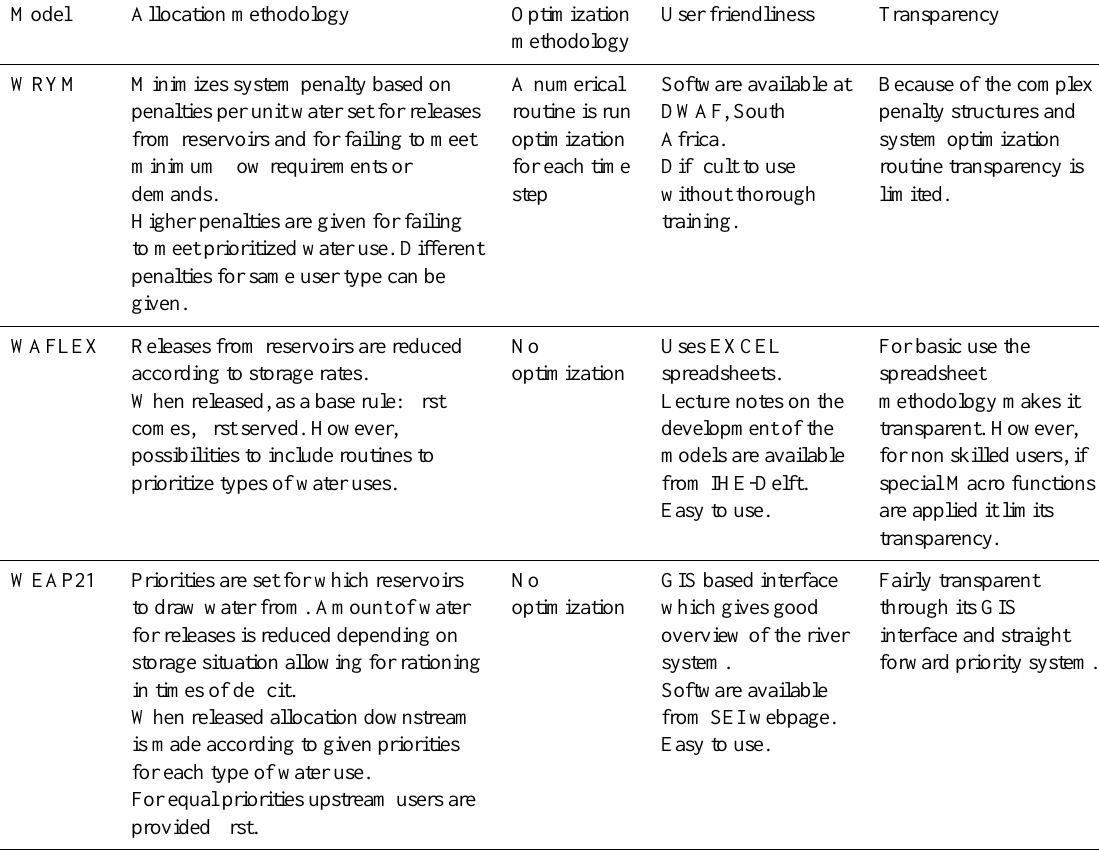
Table 4. Summarized comparison of the three system analysis models used in the study. All models run on a monthly time step.